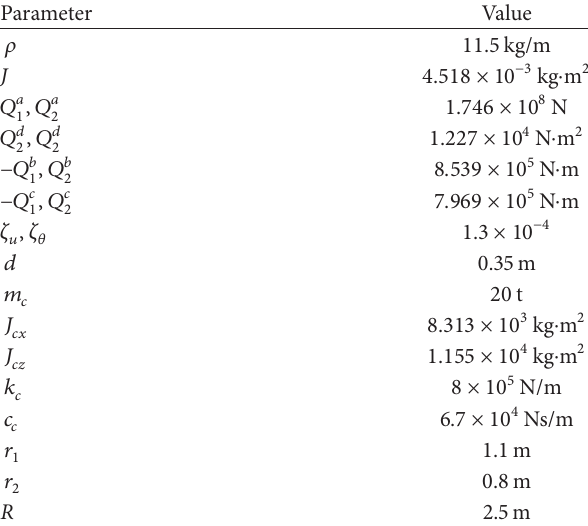
Table 1: System parameters used in calculation. Parameter